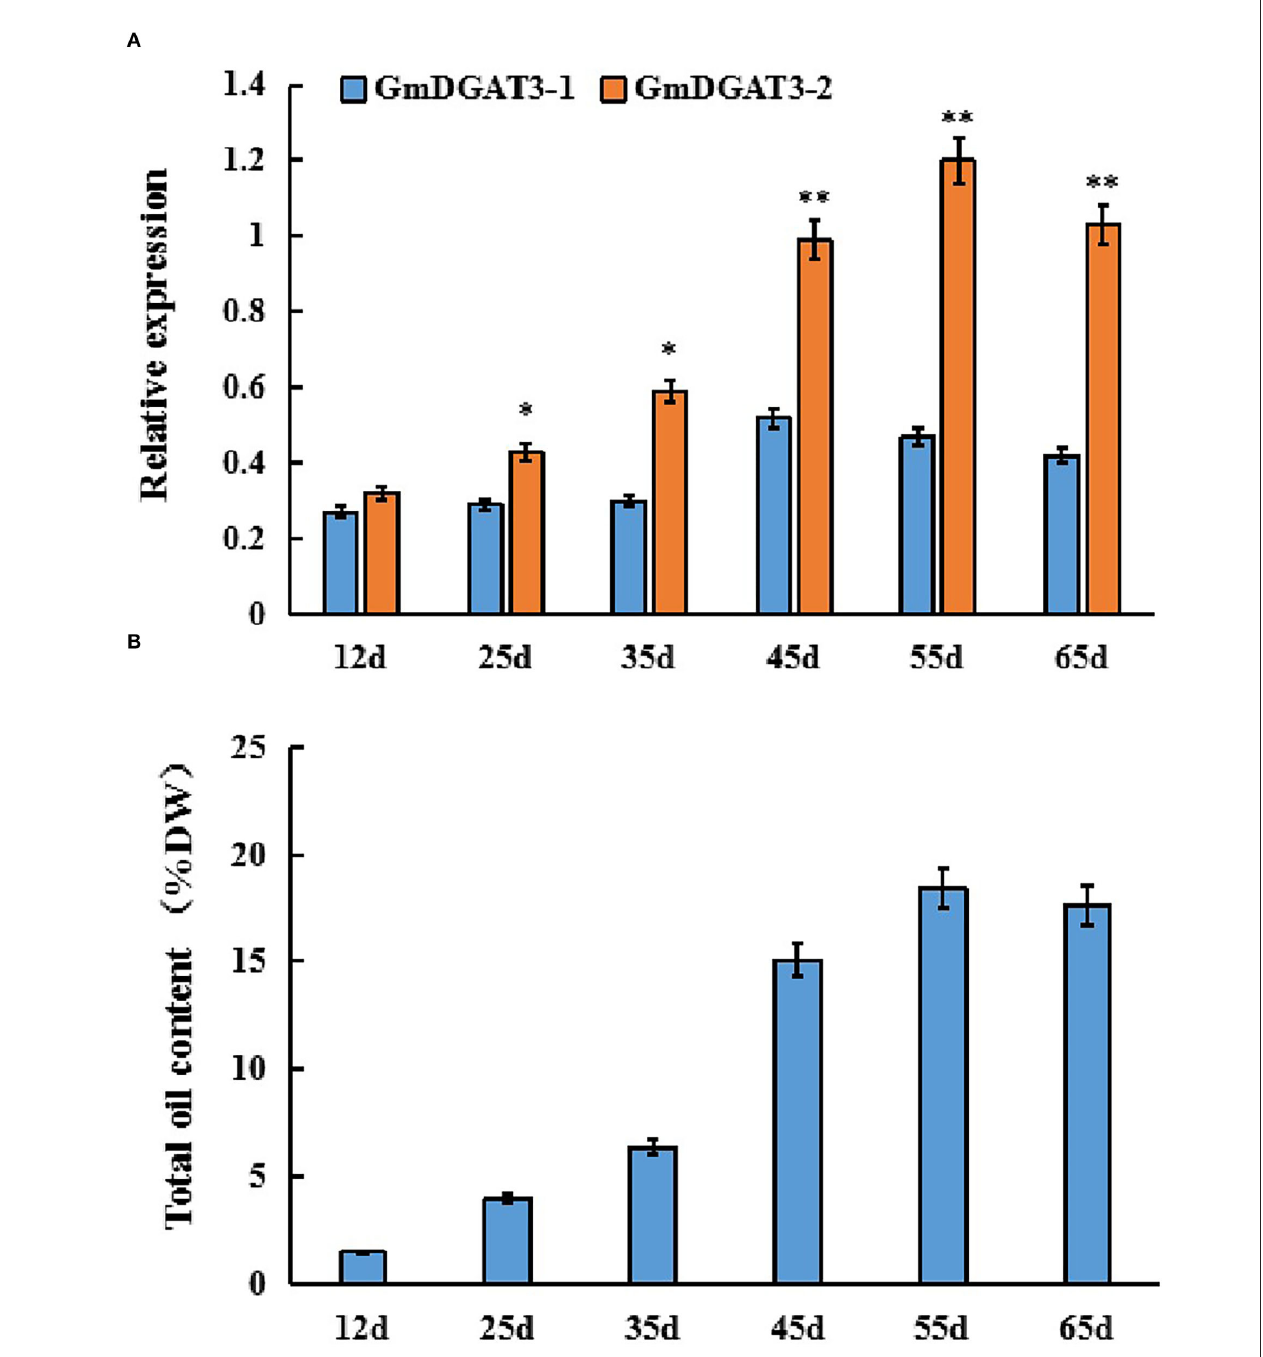
FIGURE 4 | Expression patterns of GmDGAT3 (A) and total oil content (B) during soybean seed development. The days after flowering (DAF) represent each developmental stage of soybean seeds. Data bars represent the mean ± STD level of relative transcript abundance from three biological experiments. Asterisks * and ** indicate the significant difference between GmDGAT3-1 and GmDGAT3-2 at p < 0.05 and 0.01, respectively.